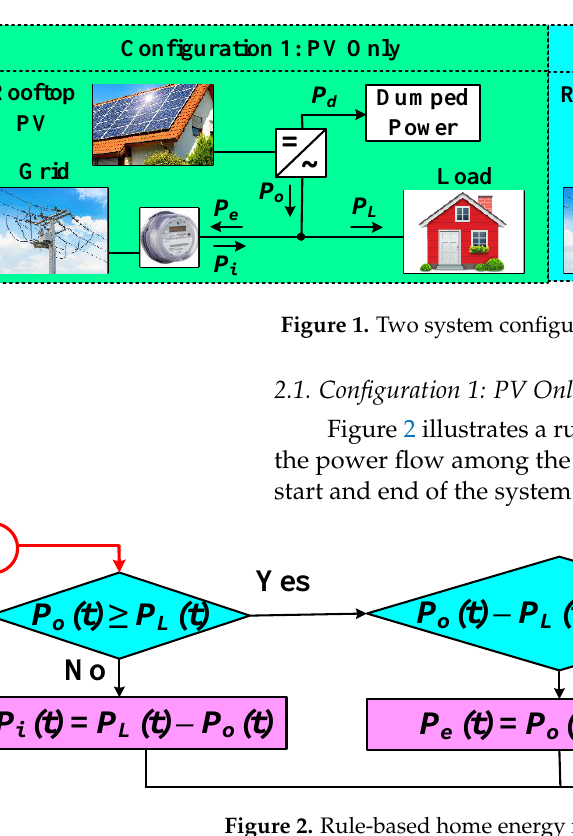
Figure 2. Rule-based home energy management system for PV only system.